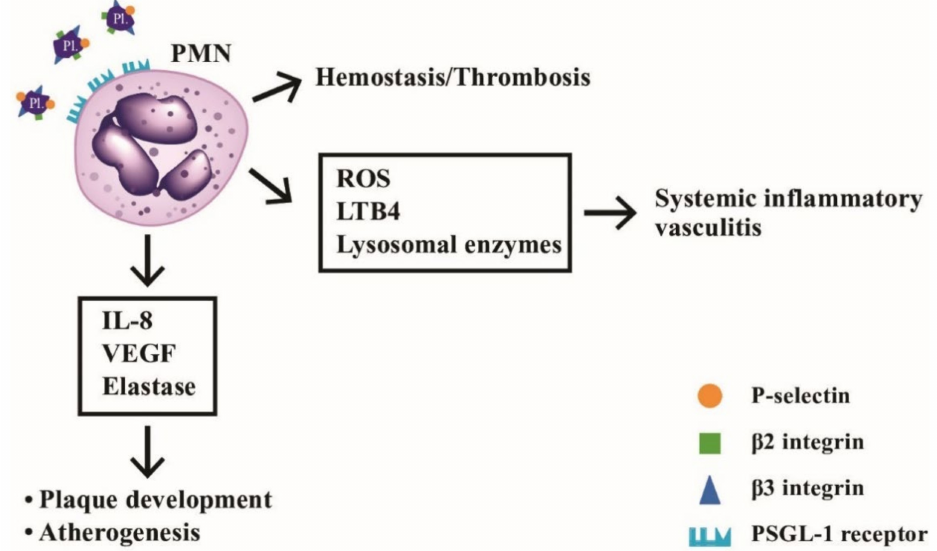
Figure 11. The interactions between neutrophils and platelets in hemostasis, thrombosis, systemic inflammatory vasculitis, and atherogenesis via binding between adhesion molecules (P-selectin, β 2-integrin and β 3-integrin) on platelets and P-selectin glycoprotein ligand-1 (PSGL-1) on neutrophils. After ligand-receptor binding, the released mediators including ROS, LTB4, and lysosomal enzymes can induce inflammatory vasculitis, whereas other factors including IL-8, VEGF and elastase can facilitate atheroma plaque development and atherogenesis in the blood vessels. LTB4: leukotriene B4; VEGF: vascular endothelial growth factor; ROS: reactive oxygen species; PL: